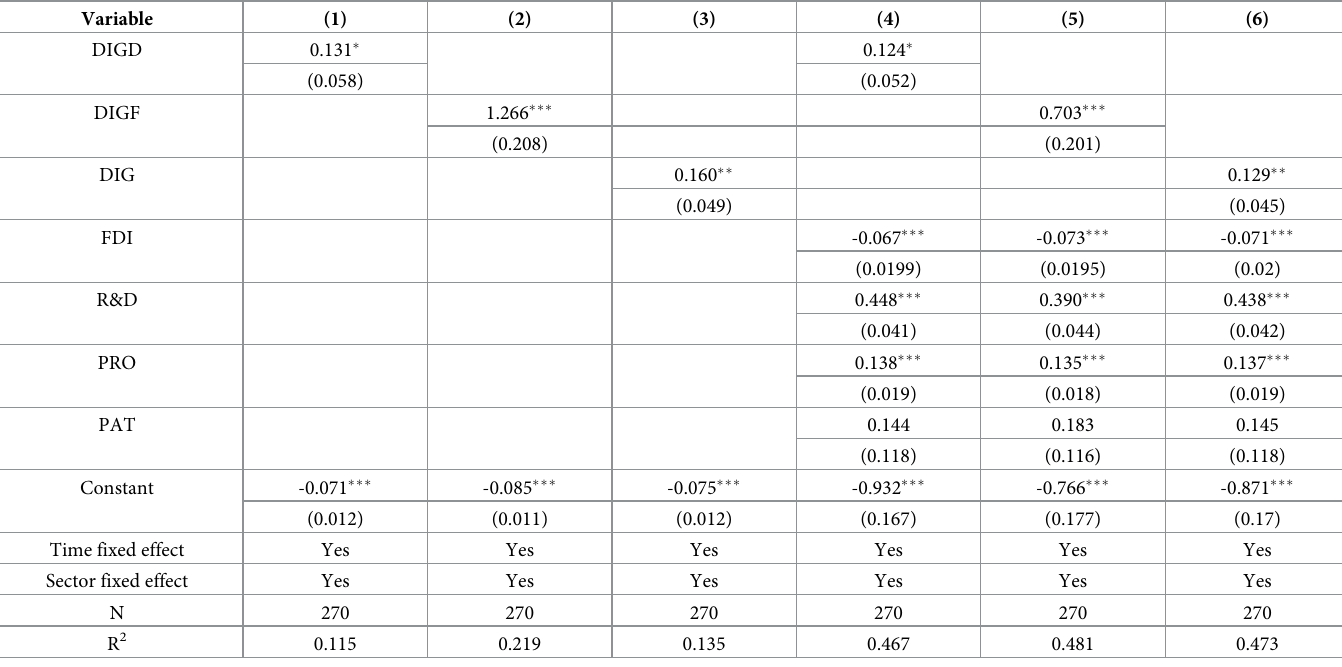
Table 3. Benchmark regression